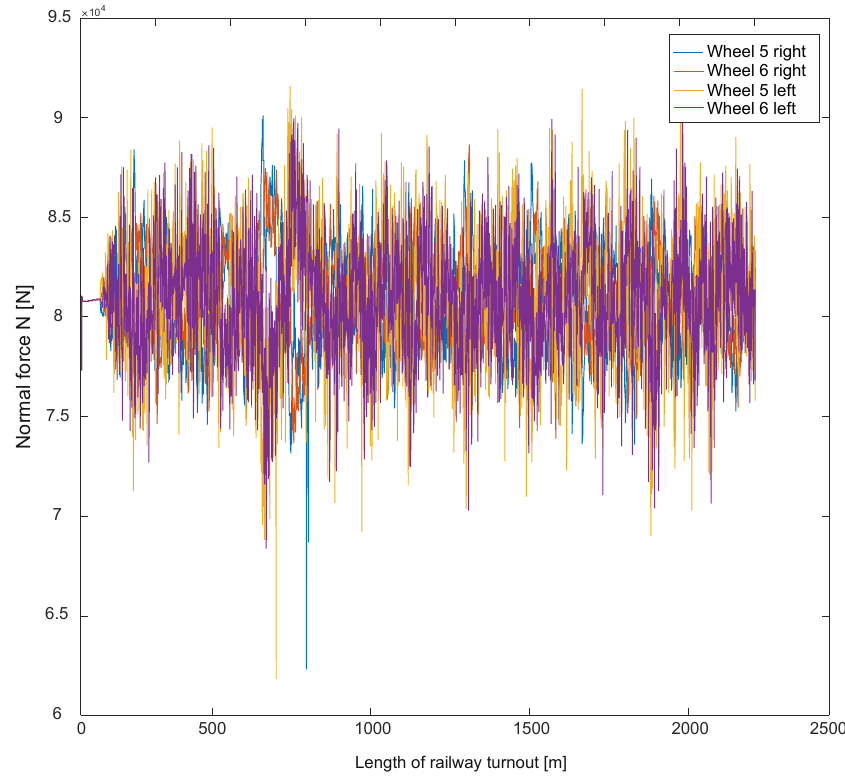
Figure 21 . Normal force at 200 km/h on a straight track without a turnout .